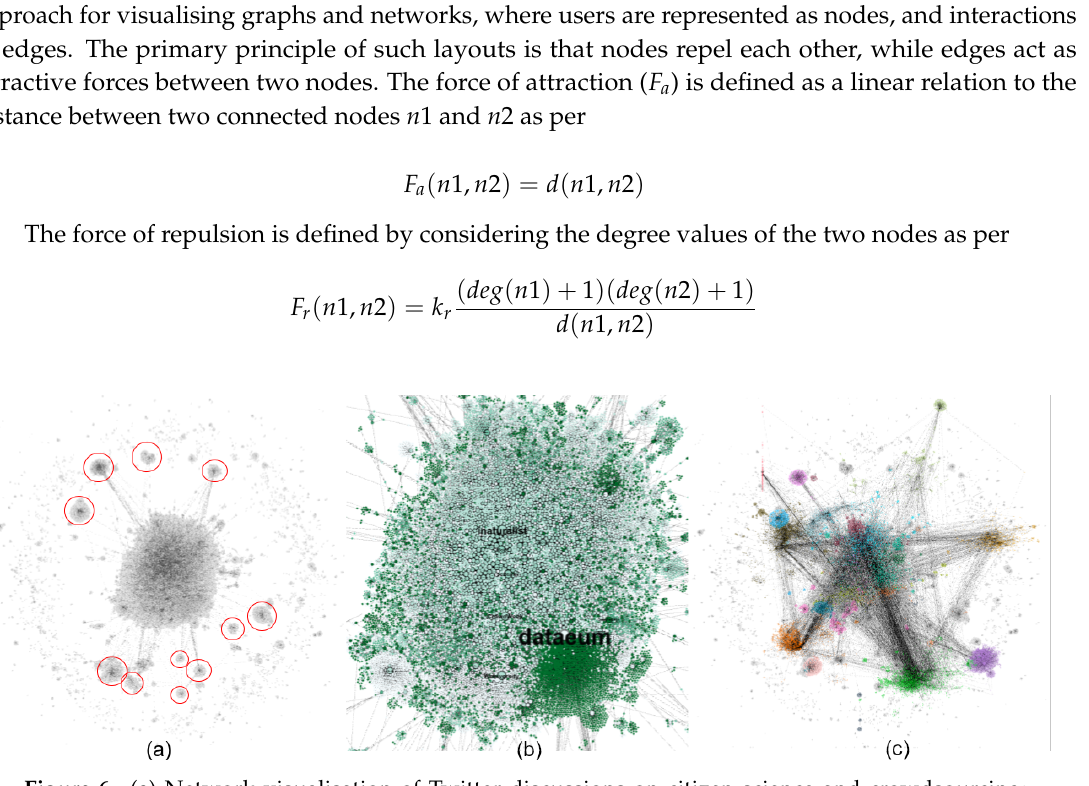
Figure 6. ( a ) Network visualisation of Twitter discussions on citizen science and crowdsourcing; ( b ) visualisation of the inner core; ( c ) visualising hubs within the inner core of the